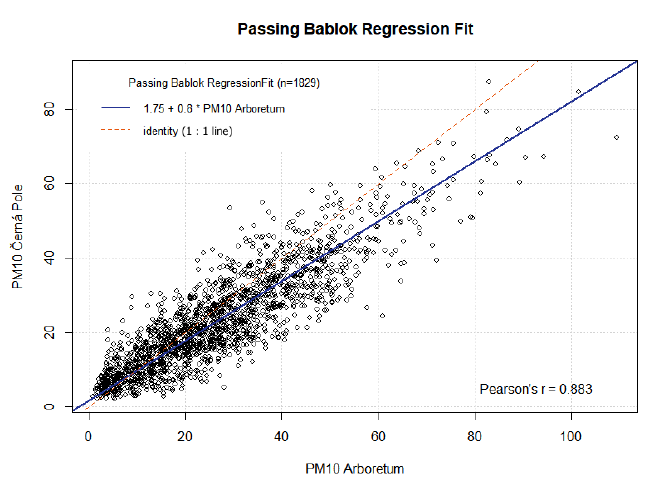
Figure 5. Passing–Bablok regression fit, PM 10 in µ g · m − 3